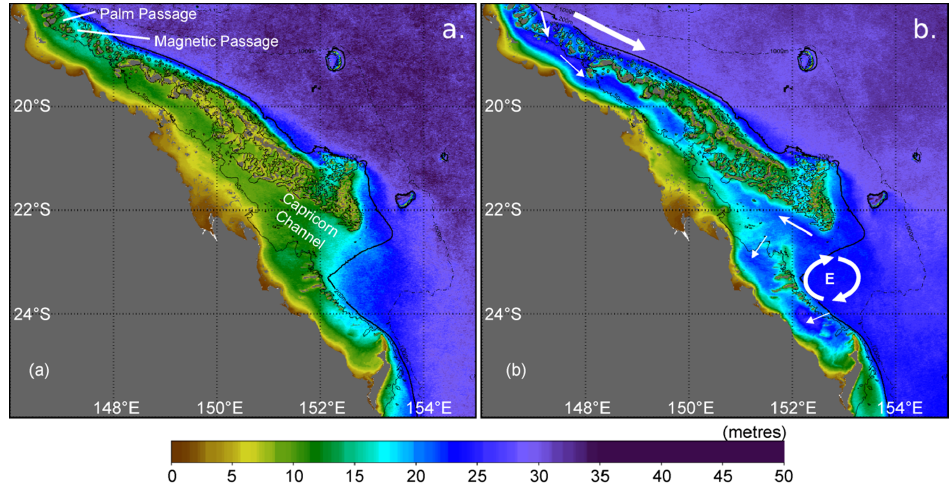
Figure 5. Long-term (2002–2012) monthly mean photic depth (m) on the central-southern Great Barrier Reef showing waters most turbid ( a ) during March and most transparent ( b ) during September. The solid black line denotes the 200 m isobath. The large white arrow represents the southward flow of the East Australian Current, with smaller white arrows showing the directions of oceanic intrusions onto the shelf. The circular arrows show the location of the Capricorn Eddy (E) that forms in the lee of the shelf bathymetry [216].